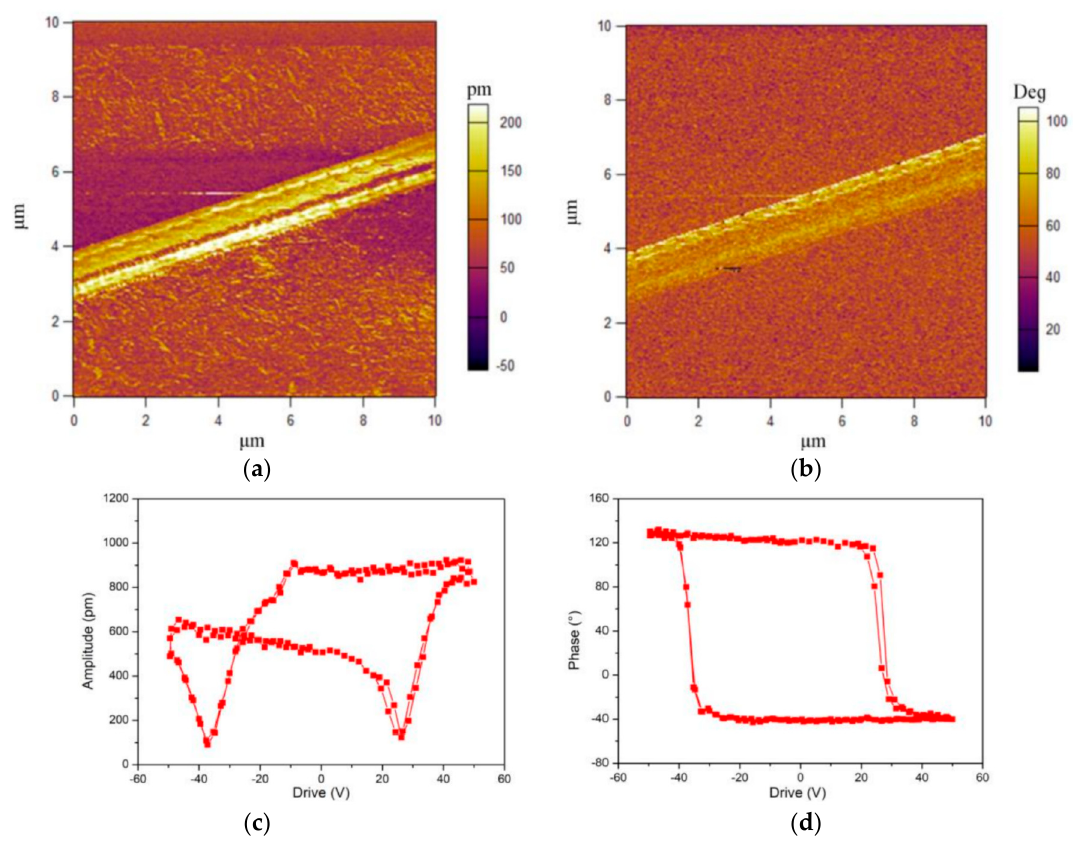
Figure 17. Piezoresponse force microscopy: ( a ) amplitude and ( b ) phase images of a single P(VDF-TrFE) nanofiber. ( c ) PFM amplitude and ( d ) PFM phase of the P(VDF-TrFE) nanofiber as functions of DC bias for two cycles, displaying good repeatability for forward and reverse scans.